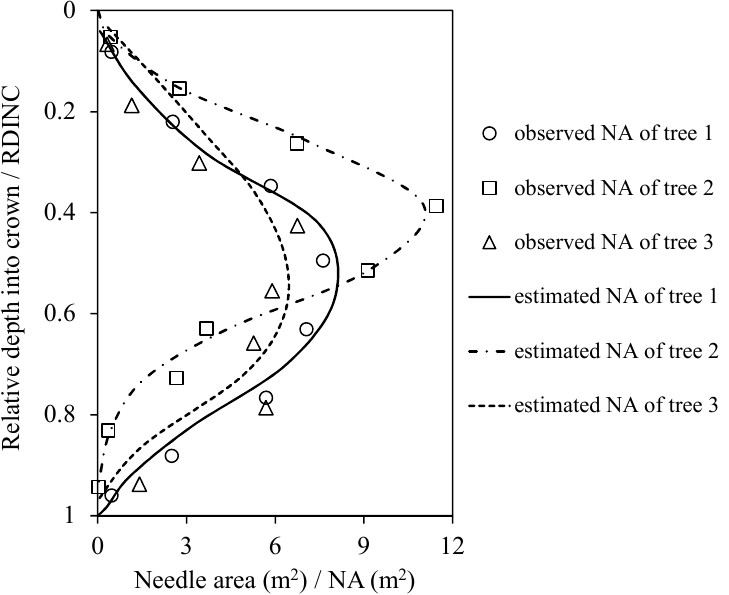
Figure 3. Description of the observed NA and corresponding estimated NA for three sample trees.